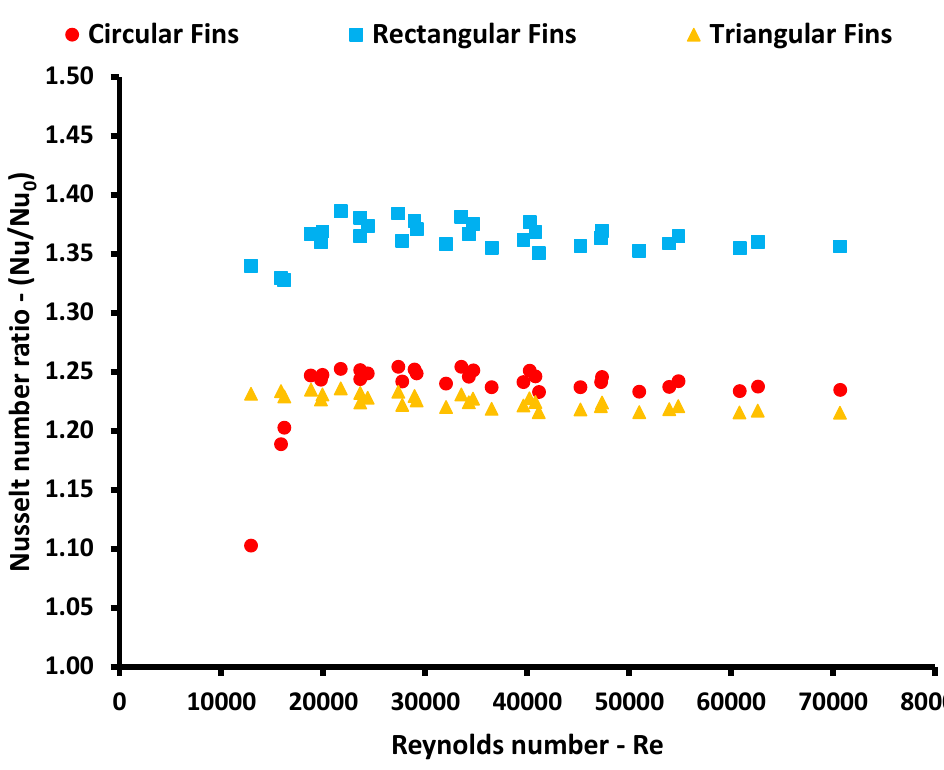
Figure 23. Nusselt number ratio in the different examined operating conditions for the different finned tubes.